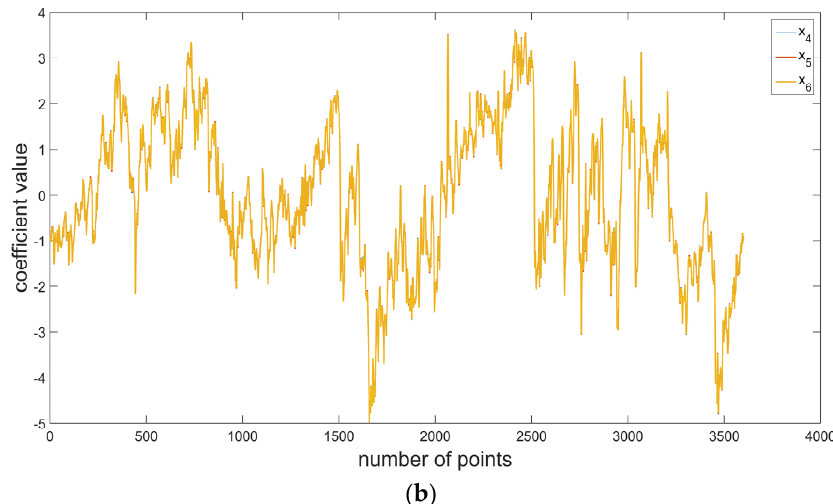
Figure 4. ( a ) A Talyrond 365 measurement of roundness profiles in a bearing roller and ( b ) a roundness profile with waviness components.